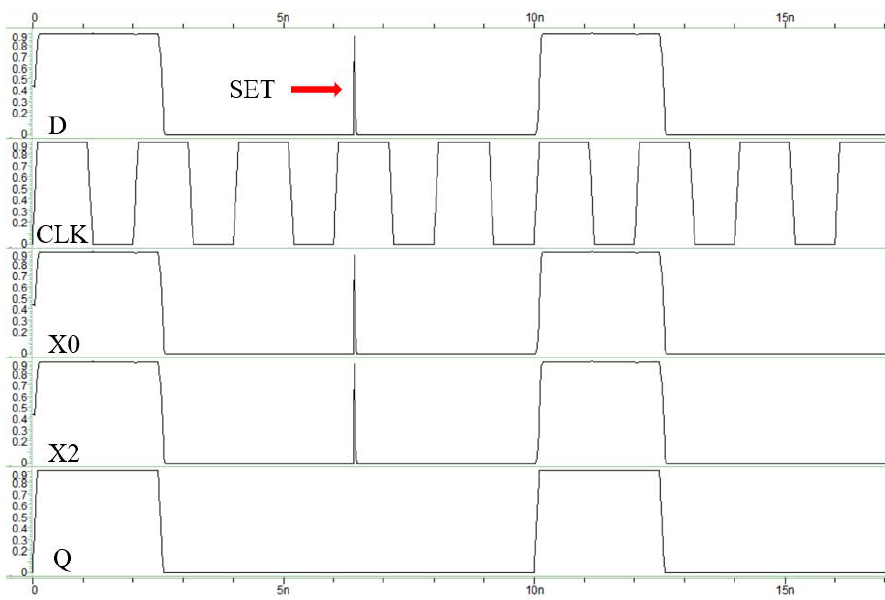
Figure 12. Simulation result during SET